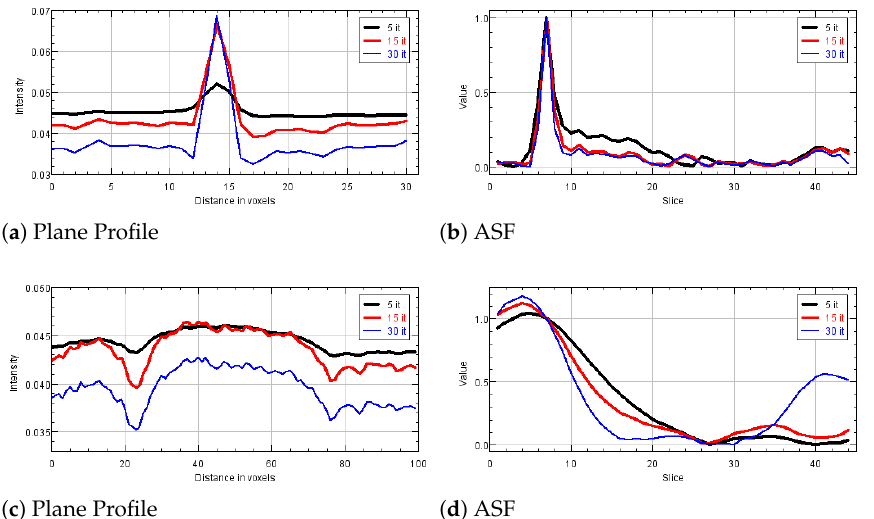
Figure 7. SGP results on BR3D phantom. Plots of the Plane Profile on the left and of the ASF vectors on the right, taken over one microcalcification of cluster 5 ( upper row ) and over mass number 2 ( bottom row ). In all the plots the black line corresponds to 5 iterations, red line to 15 iterations and blue line to 30 iterations. Table 2. Values of the Contrast-to-Noise Ratio (CNR) index computed after 5, 15 and 30 SGP iterations. The CNR value computed on microcalcifications is defined as in (25), whereas the CNR value computed on the masses is defined as in (24). 5 it.